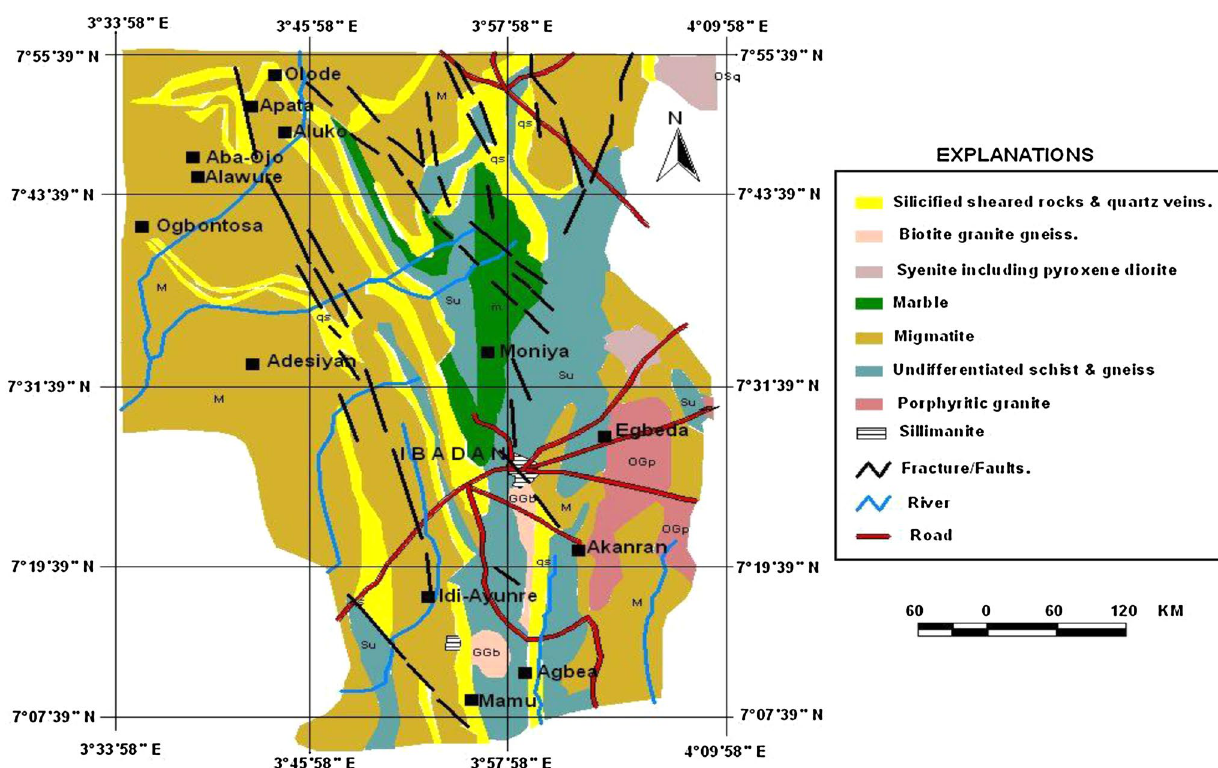
Fig. 2 Generalized geological map of Ibadan